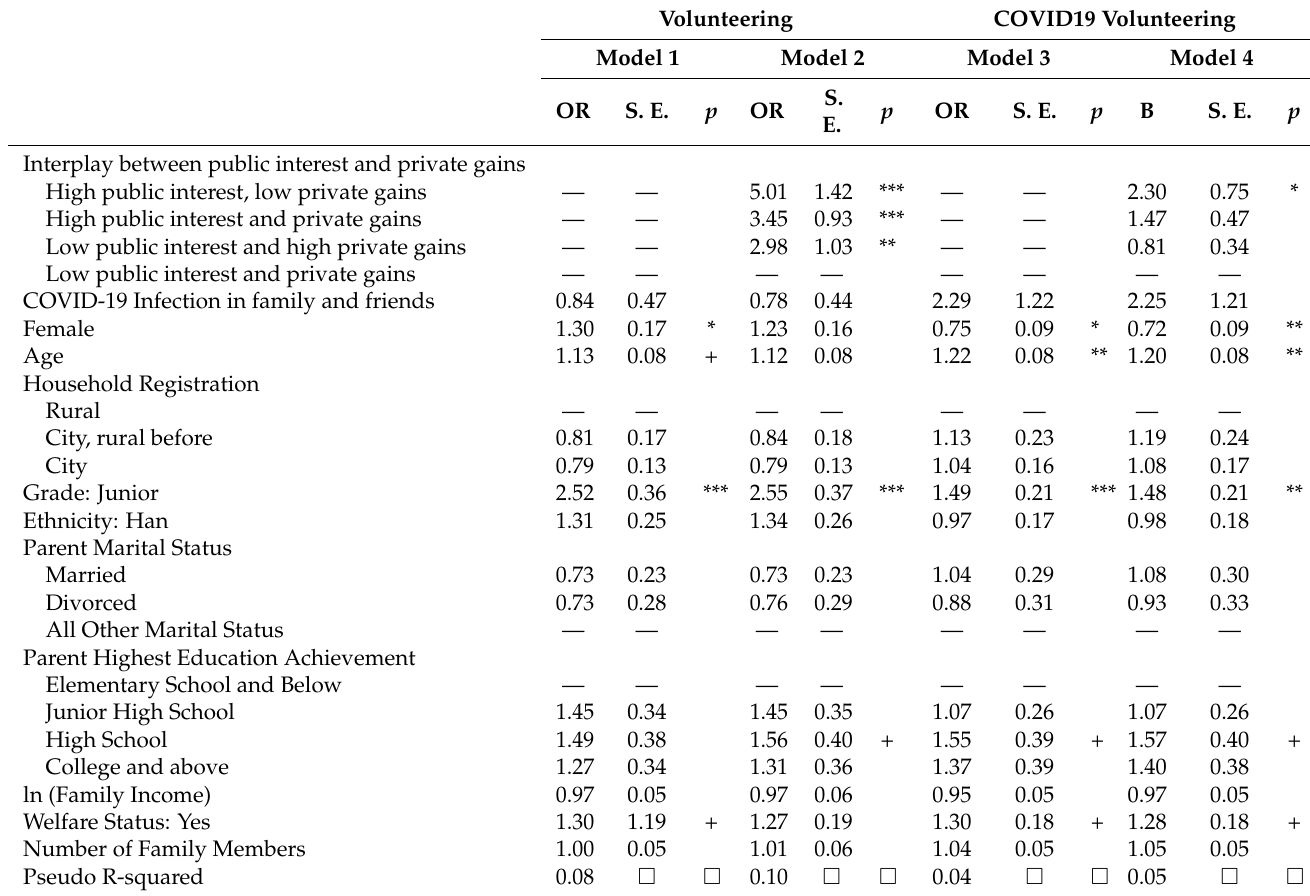
Table 2. Logit Regression Analysis of